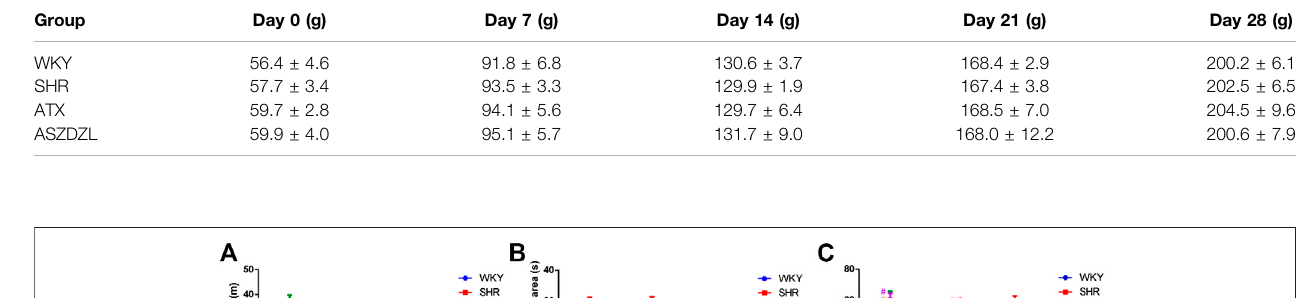
TABLE 3 | Weekly weight changes of rats in each group. Group